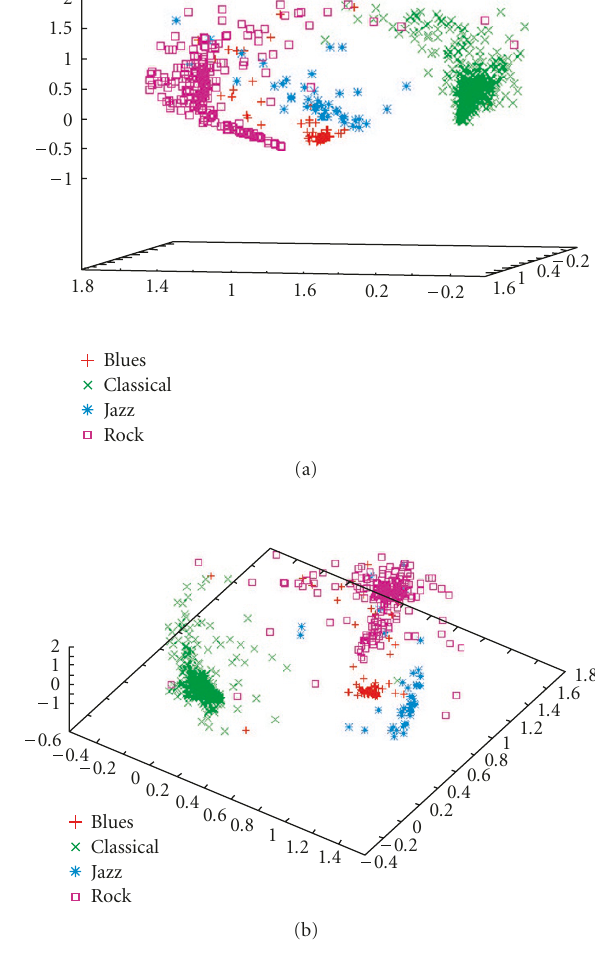
Figure 4: Two views of a 3D projection of the similarity space pro- duced by the CART-based